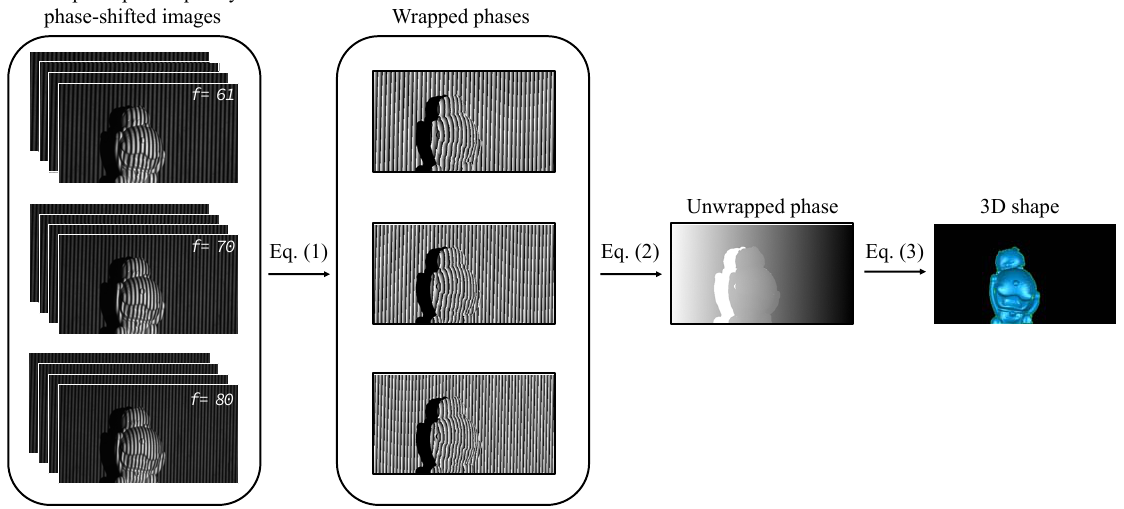
Figure 2. Pipeline of the FPP technique with triple-frequency phase-shifting